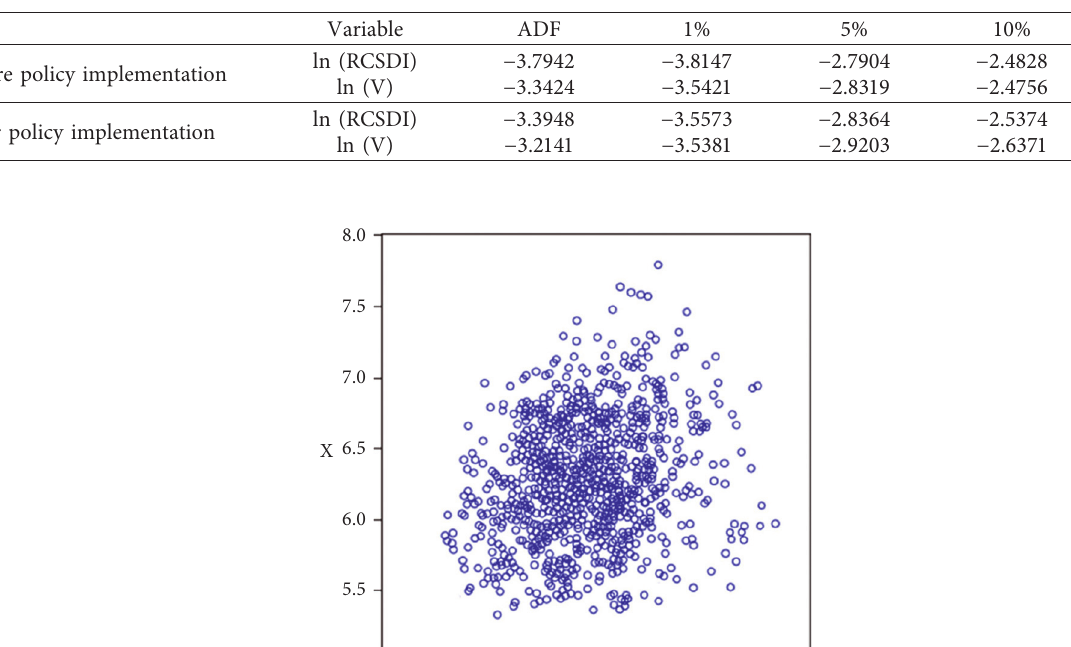
Table 3: Stationarity test results.